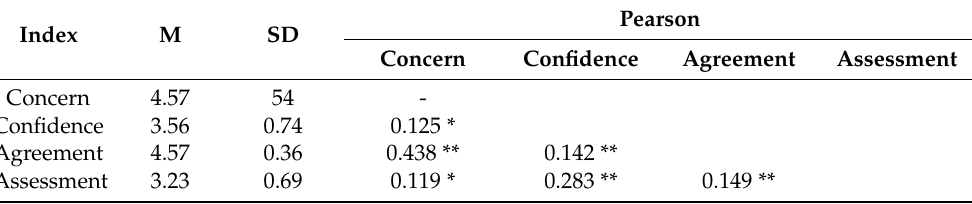
Table 3. Descriptive statistics of the different indexes and